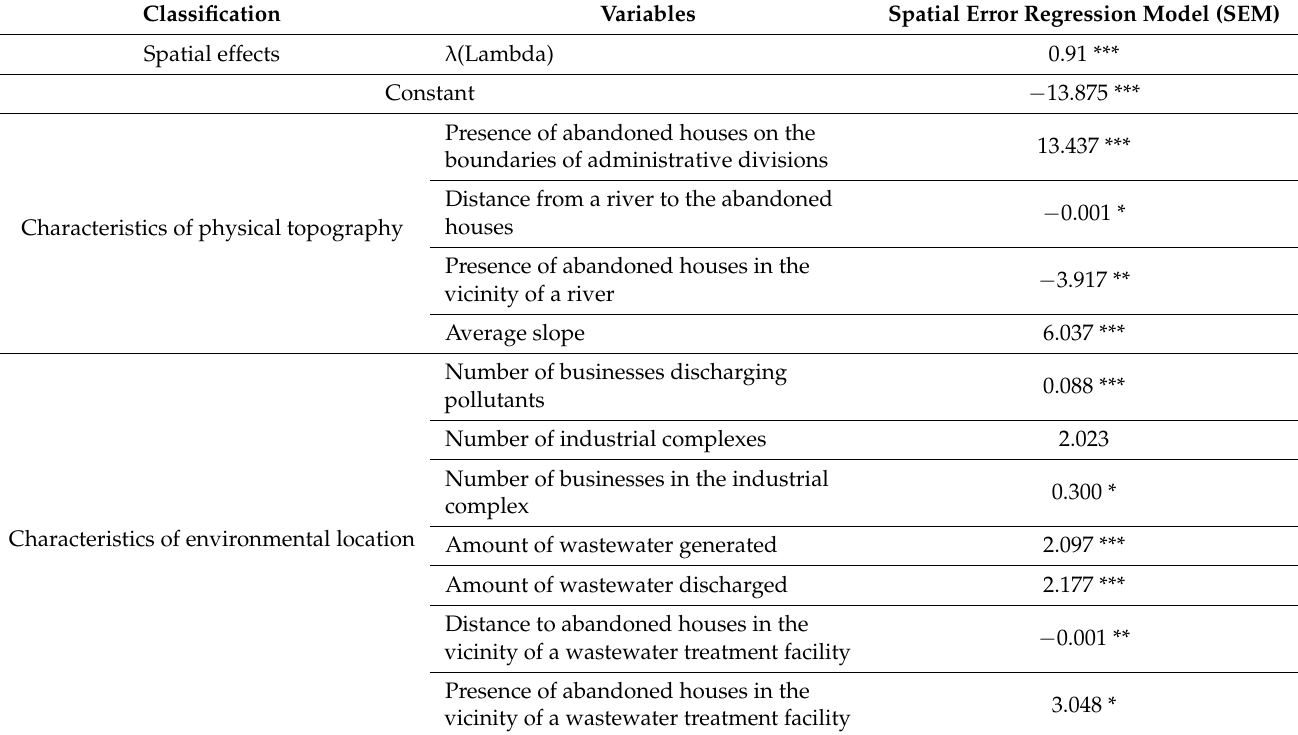
Table 4. Model estimation results.